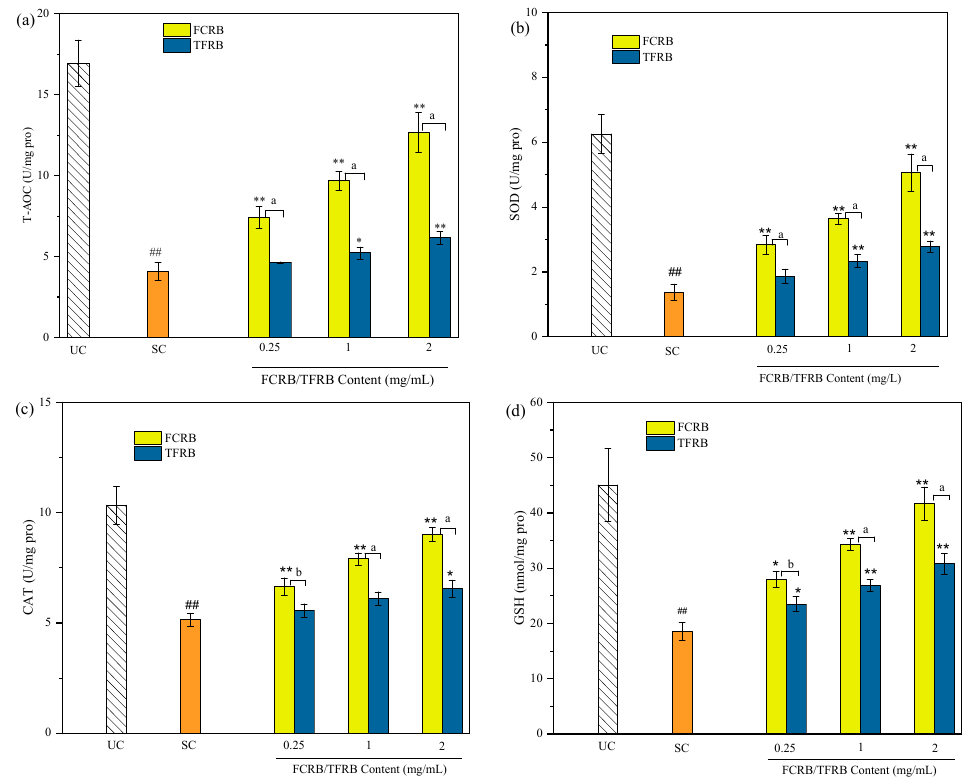
Figure 4. Effects of the FCRB or TFRB on total antioxidant capacity (T-AOC) ( a ), superoxide dismutase (SOD) ( b ), catalase (CAT) ( c ) and glutathione (GSH) levels ( d ) in Caco-2 cells. UC, untreated controls; SC, stress controls treated with 1 mM H 2 O 2 only. The results are presented as means ± SD ( n = 3). ## p < 0.01 vs. UC; * p < 0.05, ** p < 0.01 vs. SC; a p < 0.01 vs. TFRB (at the same concentration); b p < 0.05 vs. TFRB (at the same concentration) as determined by using the one-tailed T test.